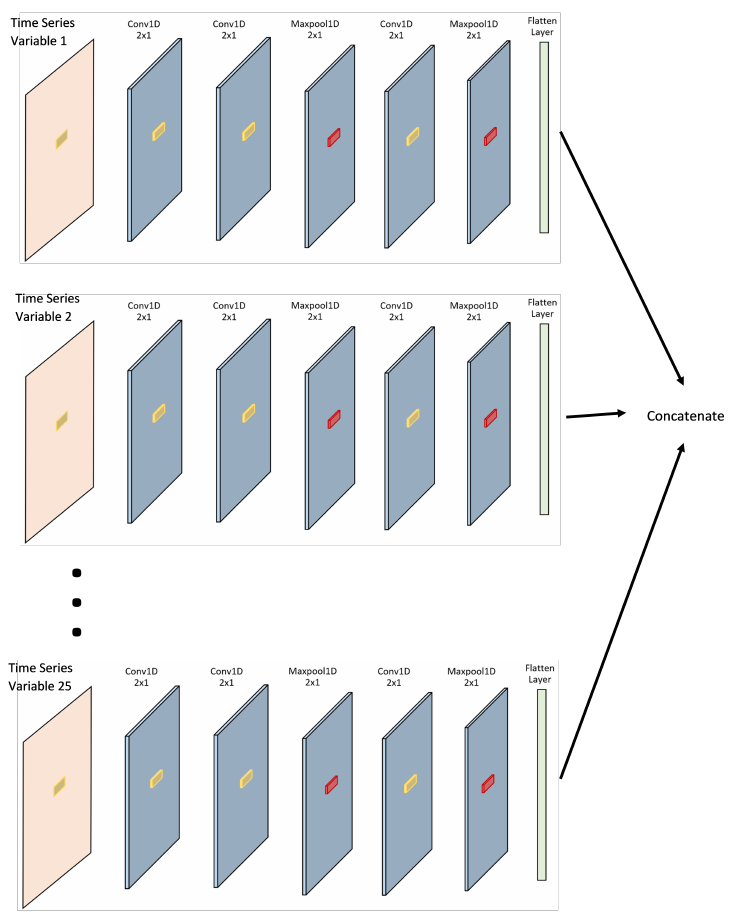
Figure 7. Convolution and maxpool Layers for multihead